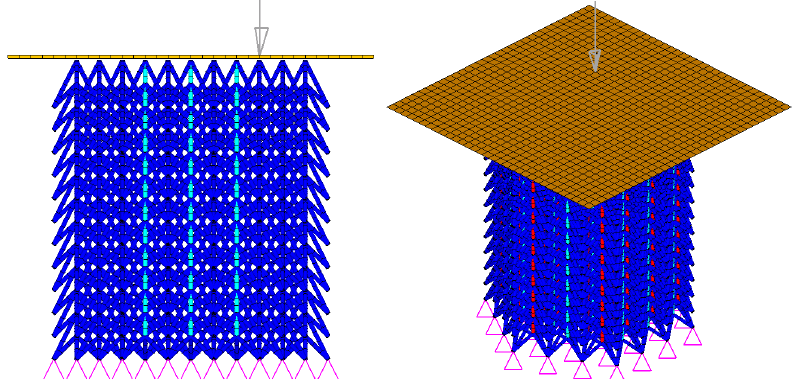
Figure 19. The FE model of NPR lattice structure .